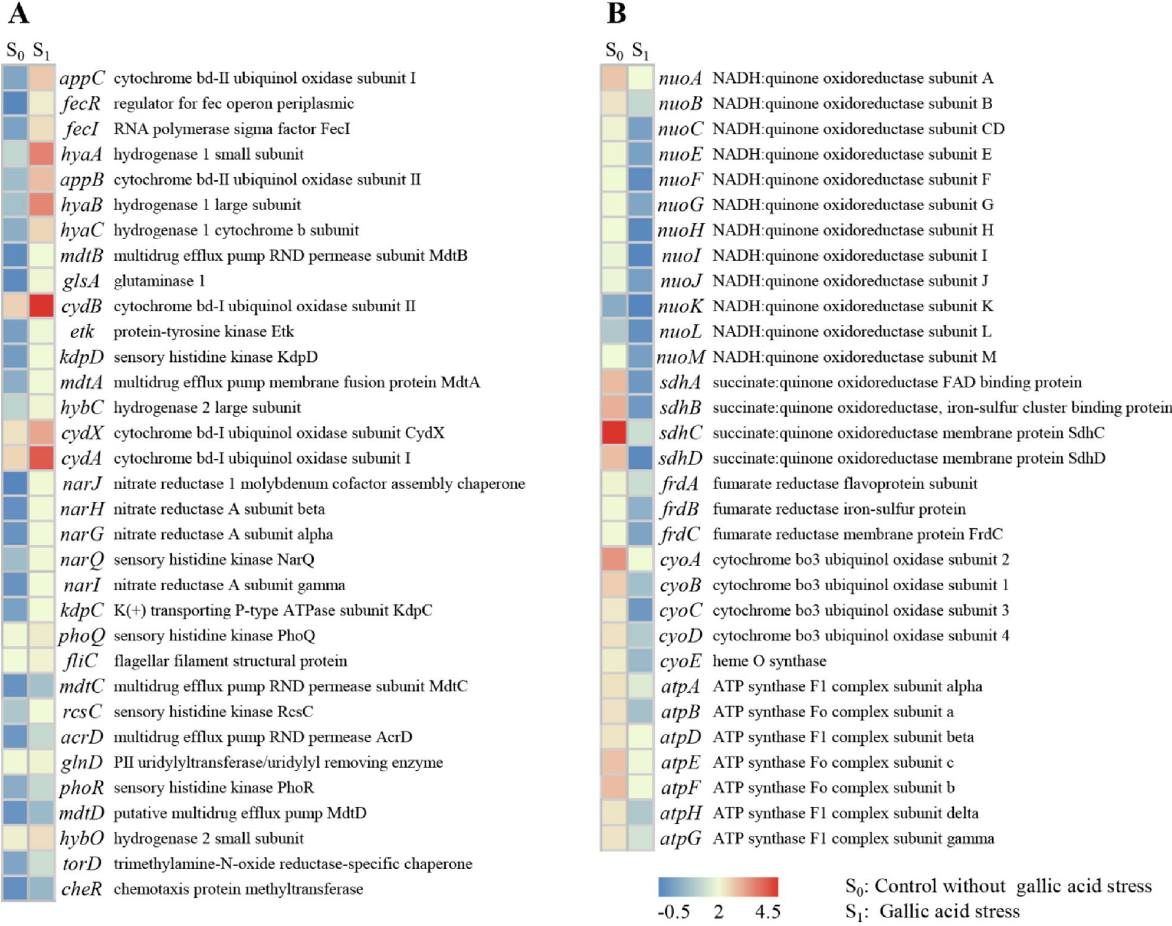
Fig. 6 Heatmap of genes related to the A Two-component system, B energy metabolism. Z scores were utilized to show the transcription characteristics with a